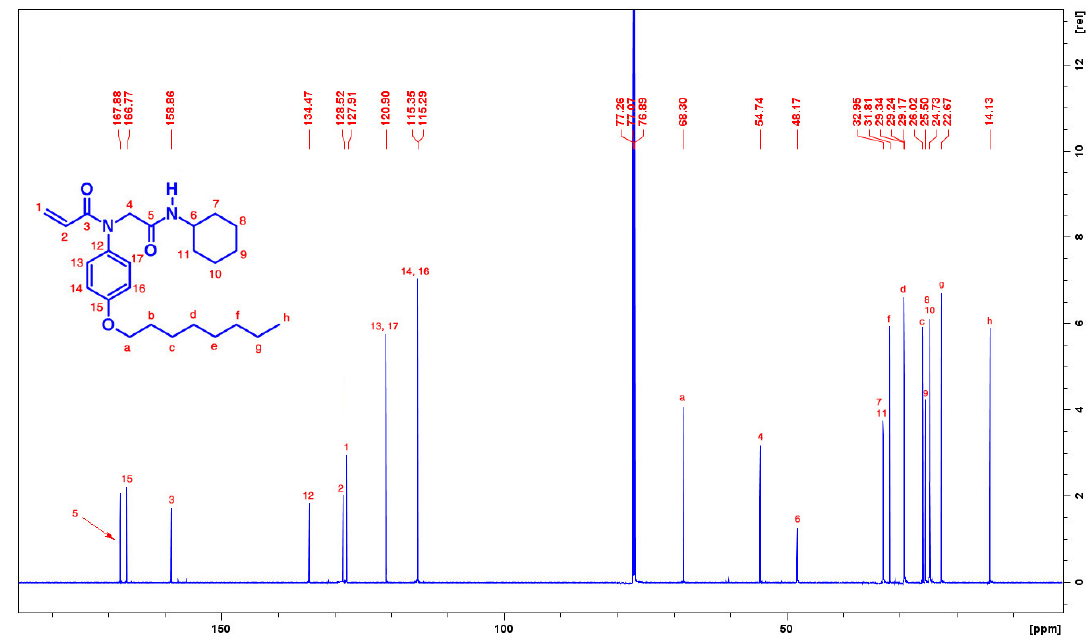
Figure 2. 13 C ‐ NMR spectra of desired compound (176 MHz, CDCl 3 ) at room temperature. Figure 2. 13 C-NMR spectra of desired compound (176 MHz, CDCl 3 ) at room